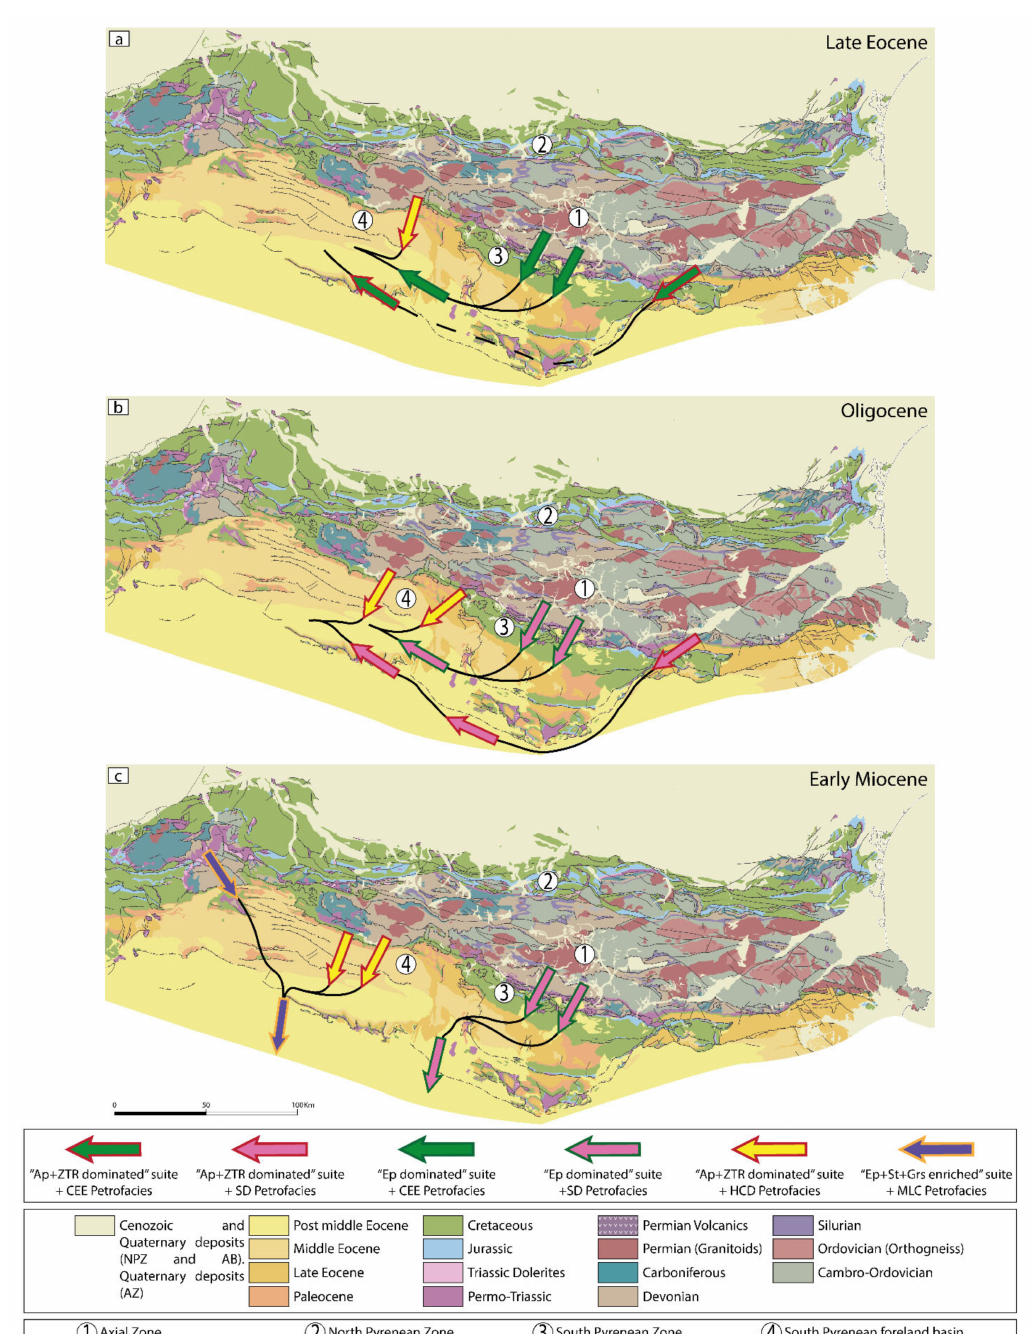
Figure 11. Summary of source areas and sediment routings in the South Pyrenean Basin from late Eocene to early Miocene displayed in a present-day map, not restored. Coarse arrows indicate composition of source areas (stroke color: heavy-mineral suite, fill: petrofacies). Thin arrows indicate sediment routing approximately. ( a ) Late Eocene routing systems. Two different axially-fed east sourced systems (one more meridional) coexist with a transverse-fed north sourced system supplying the Jaca basin. ( b ) Oligocene routing systems. Two different axially-fed east sourced systems (one more meridional) coexist with two transverse-fed north sourced systems supplying the Jaca basin. ( c ) Early Miocene routing systems. Two different transverse-fed north sourced systems supply sediment to the Ebro basin in the western area, whereas in the eastern part, two transverse-fed north sourced systems supply the Huesca